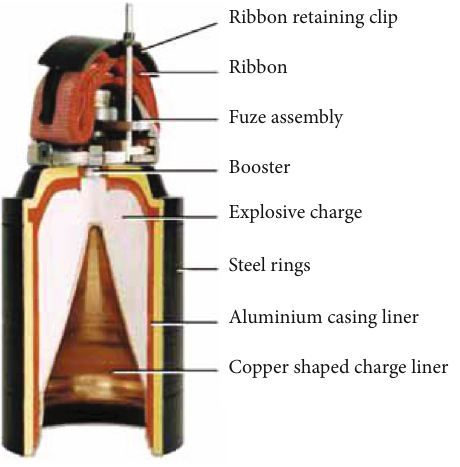
Figure 1: Typical submunition